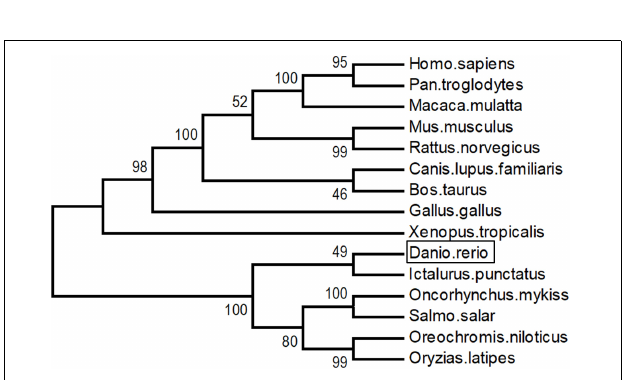
FIGURE 6 | Gli1-luc reporter activities from HH reporter cell line Light2 cultured alone (–) with HeLa-EV (EV, empty vector, pcDNA6-Myc), HeLa-HuZeLZTFL1 (pcDNA6-Myc-HuLZTFL1), or HeLa-ZeLZTFL1 (pcDNA6-Myc-ZeLZTFL1). Luciferase reporter assay indicated that the LZTFL1 of both human and zebrafish can suppress HH signaling. Each bar represents the mean ± SEM of at least five samples. The asterisks denote statistically significant differences between the indicated samples. ∗∗ p < 0.01. ZeLZ, pcDNA6-Myc-ZeLZTFL1 (zebrafish LZTFL1 was inserted into pcDNA6-Myc). HuLZ, pcDNA6-Myc-HuLZTFL1 (human LZTFL1 was inserted into